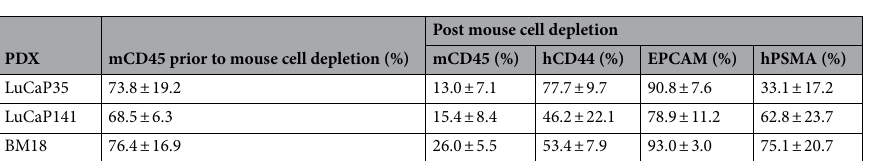
Table 1. Marker expression before and after mouse cell depletion. Values represent averages ± standard deviations. LuCaP35 analysis from n = 6 PDX tumours, LuCaP141 analysis from n = 5 PDX tumours, and BM18 analysis from n = 3 tumours. Graphical data is provided in Supplementary Fig.